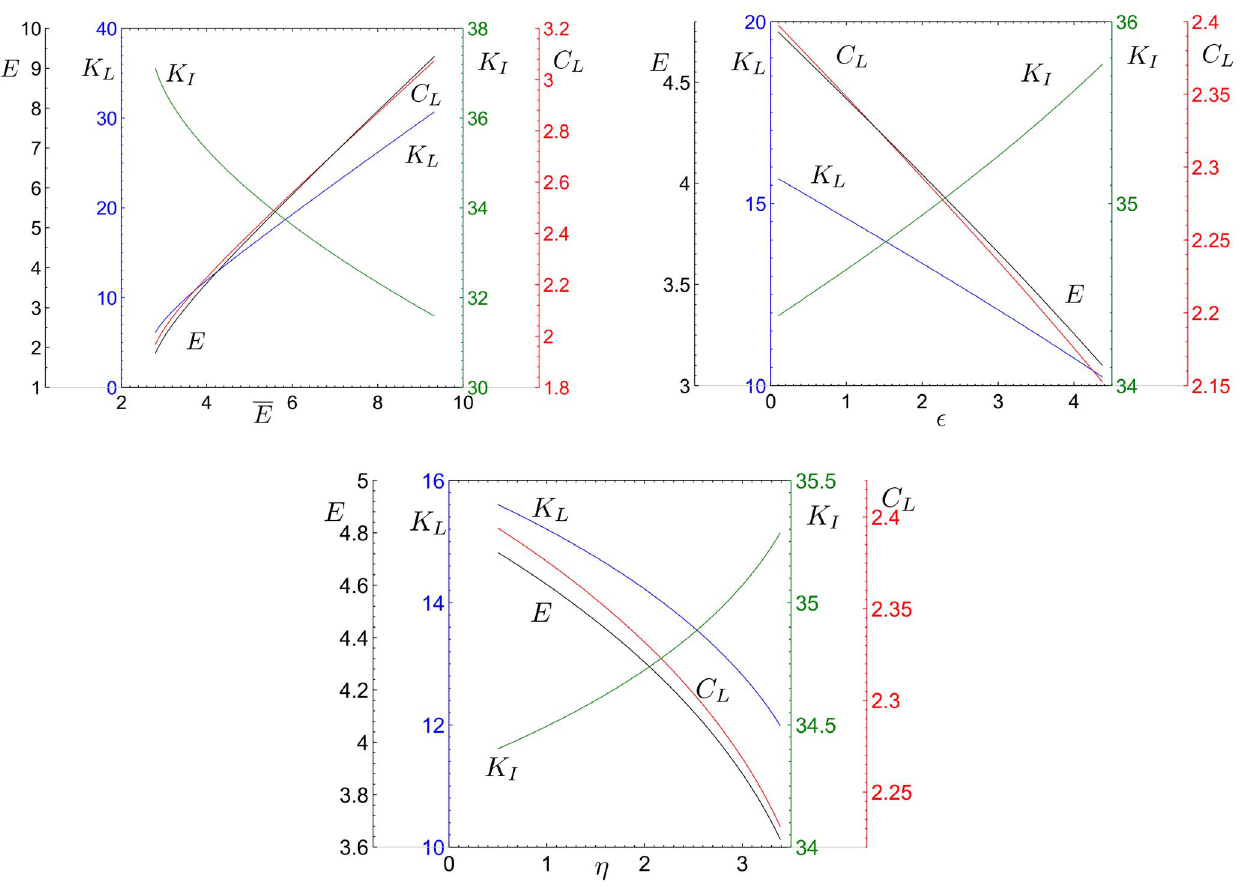
, K (cid:2) , E (cid:2) , L (cid:2) , Y (cid:2) and C (cid:2) evaluated at B , varying the parameters E , E and g ; the other parameters are fixed at the values : a ~ 0 : 1 , L I I L